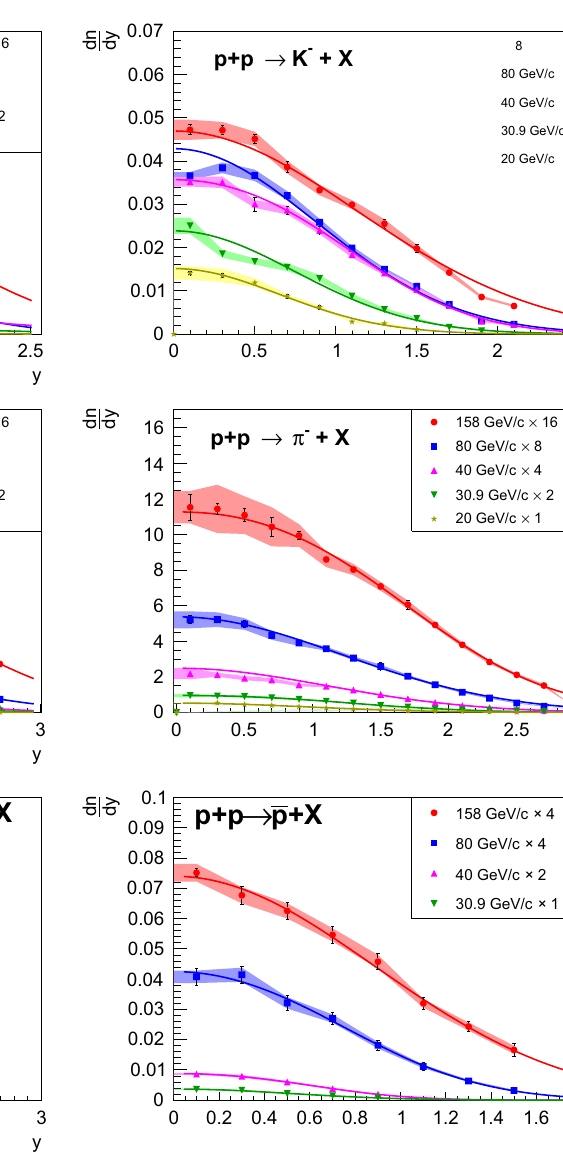
positively charged particles at SPS energies with statistical and systematic uncertainties